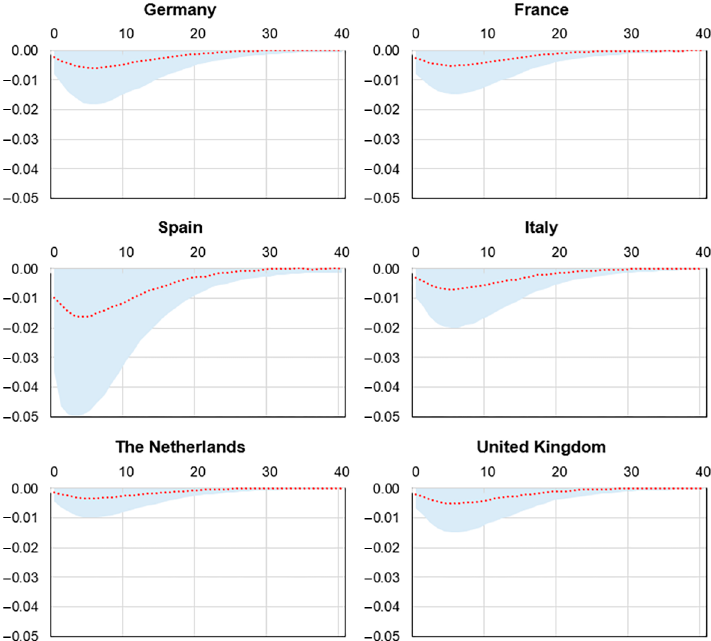
Figure 5. Impulse response functions of a one standard deviation supply shock in US on the selected developed European countries economic growth (source: authors’